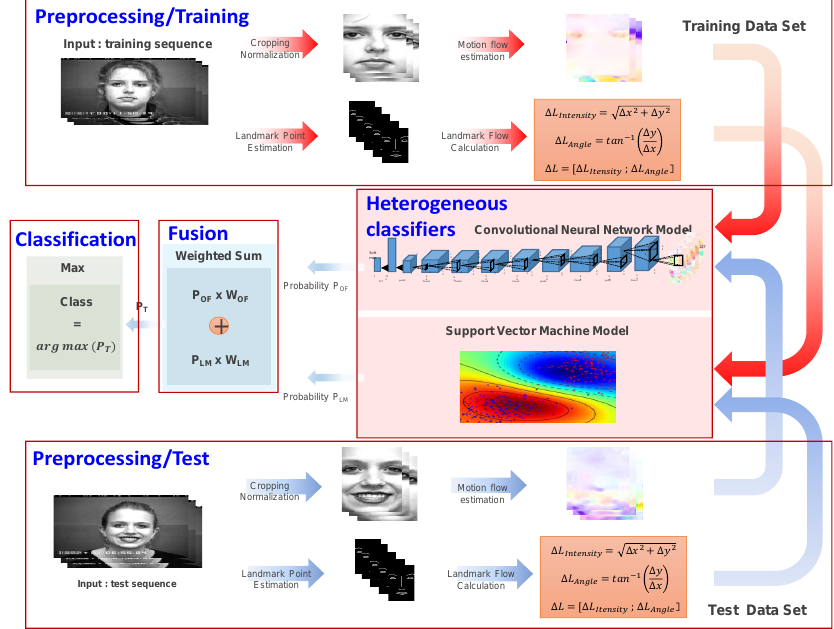
Figure 1. Block diagram of facial expression recognition using mixture of CNN and SVM classifier.